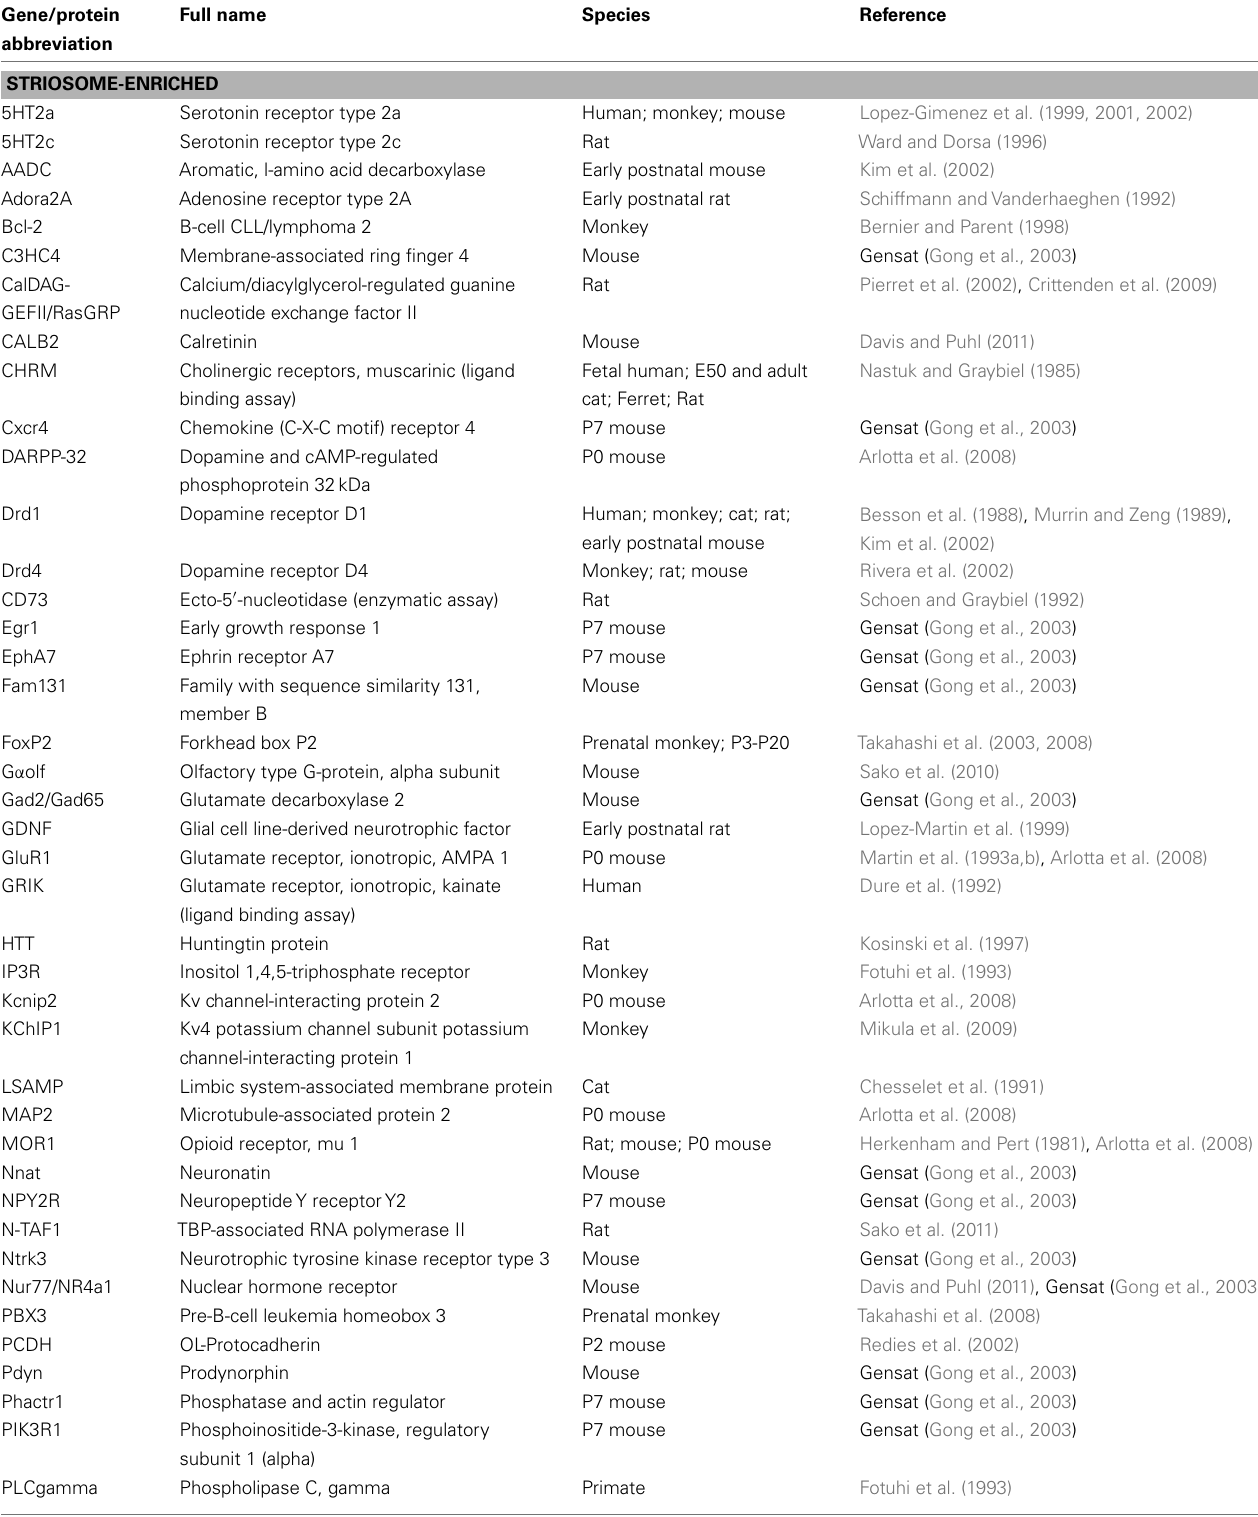
Table 1 | Molecules with differential expression between the striosome and matrix compartments of the dorsal